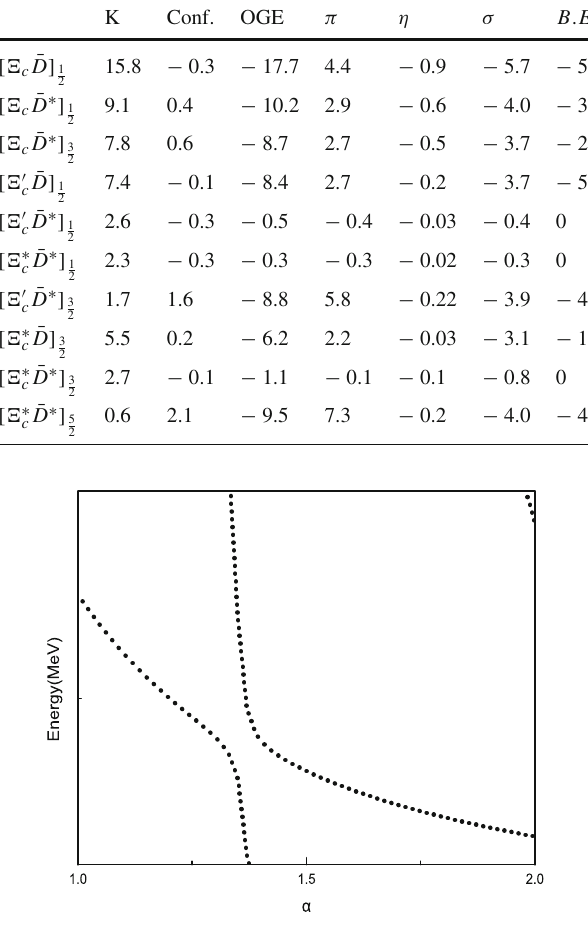
other continuum states will fall off towards its threshold. If the avoid-crossing structure is repeated periodically as α increase, then the avoid-crossing structure is a genuine reso- nance [41]. the thresholds of all physical channels appear as horizon- tal lines and are marked with lines (red lines), tagged with their contents. And for genuine resonances, which appear as avoid-crossing structure and are marked with blue lines. The continuum states fall off towards their respective threshold states (red horizontal